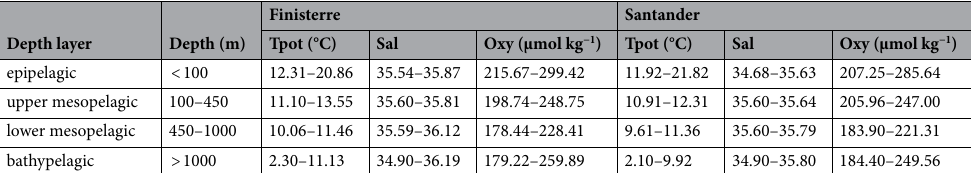
Table 1. Range of vertical variability of the hydrographic features measured along the Finisterre and Santander sections (north-east Atlantic Ocean): potential temperature (Tpot), salinity (Sal) and dissolved oxygen concentration